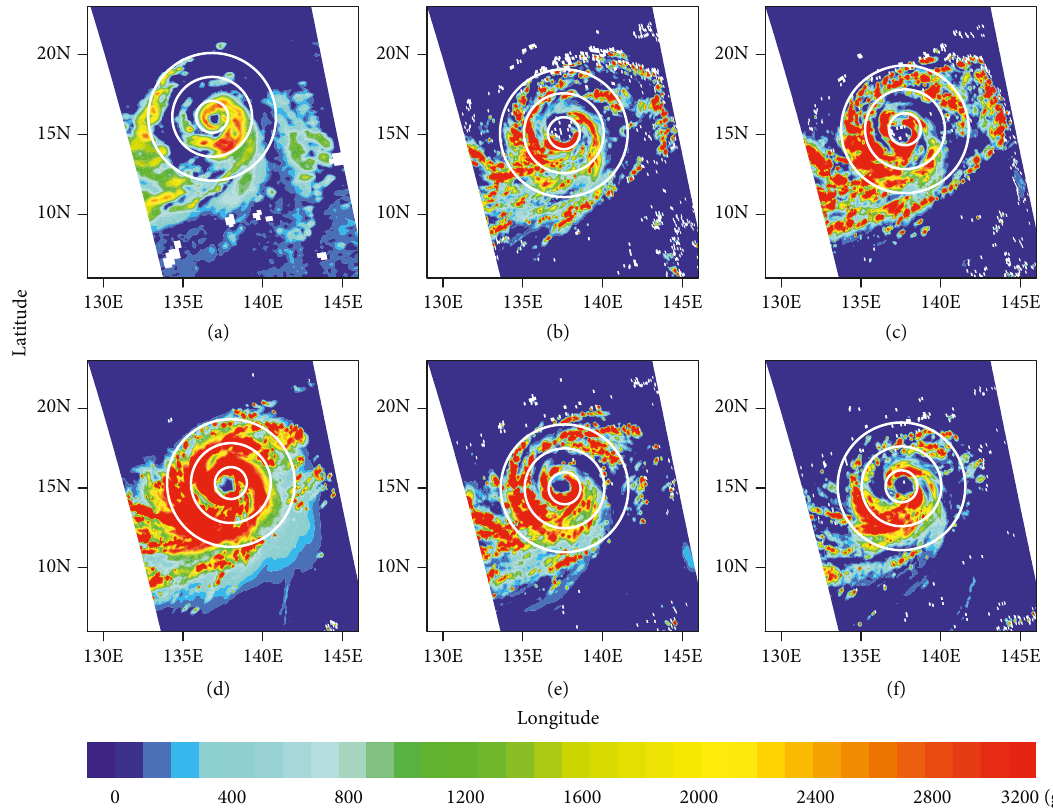
Figure 5: Horizontal distribution of FY-3B retrieved IWP (a) and model-simulated frozen precipitation (graupel and snow) produced with the supertyphoon Neoguri, using the cloud microphysical schemes of (b) WSM6, (c) GSFC, (d) THOM, (e) MORR, and (f) NSSL, based on matched instances of 0705A. Three white rings are 1 ° , 2.5 ° , and 4 ° radius annuli, respectively. Table 3: Statistics of the domain-averaged frozen precipitation path (g m − 2 ) in sample by the annular region, from the simulation using five MPSs, combined with FY-3B retrieval ice water path (IWP; g m − 2 ), based on the matched instances of 0705A. Frozen precipitation